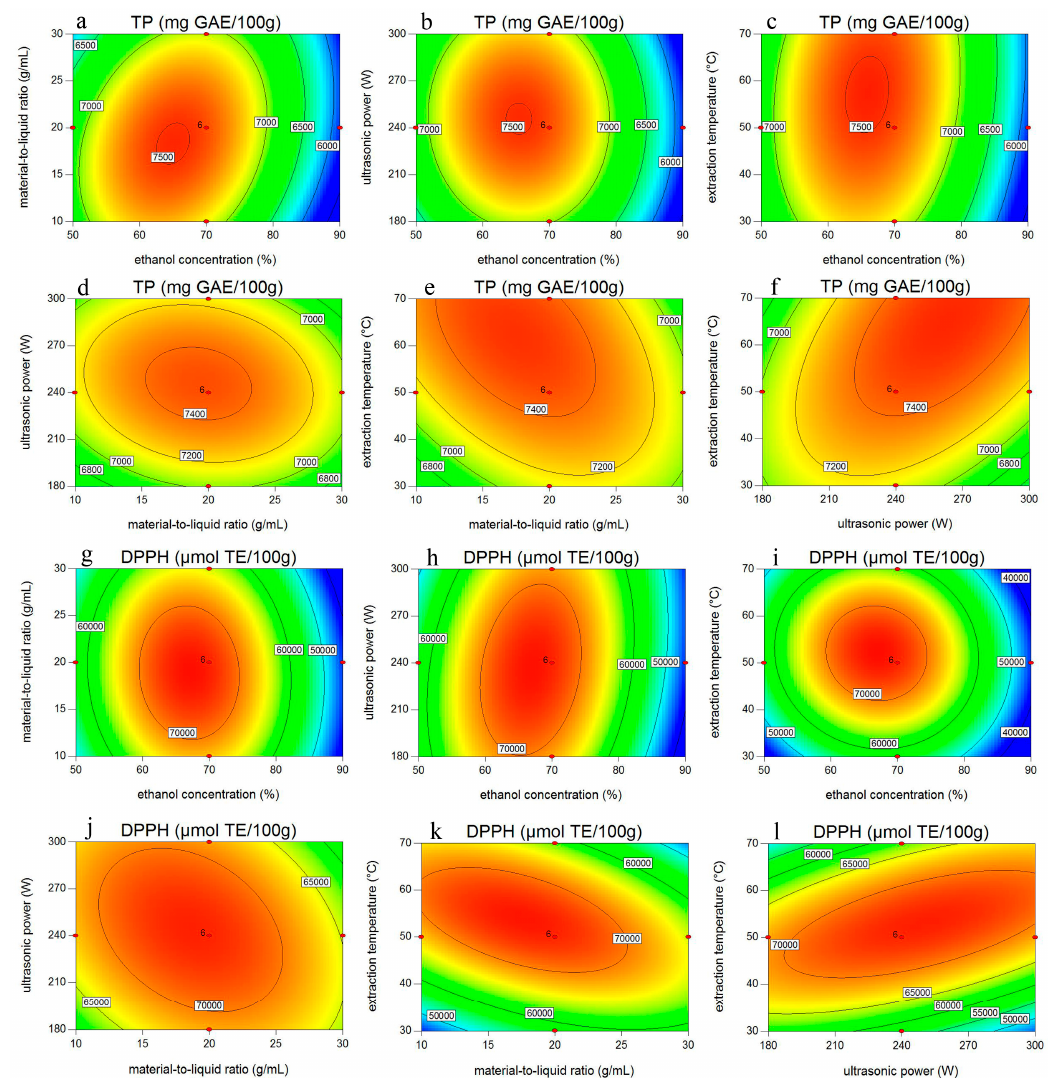
Figure 2. Contour plots showing the effects of four variables (solvent concentration, material to liquid ratio, ultrasonic power, and extraction temperature) and their interactions on extraction efficiency of total phenols (TP, a – f ) and their DPPH • scavenging capacity ( g – l ). The other two variables in each of the Figures were kept constant at their respective central experimental values.